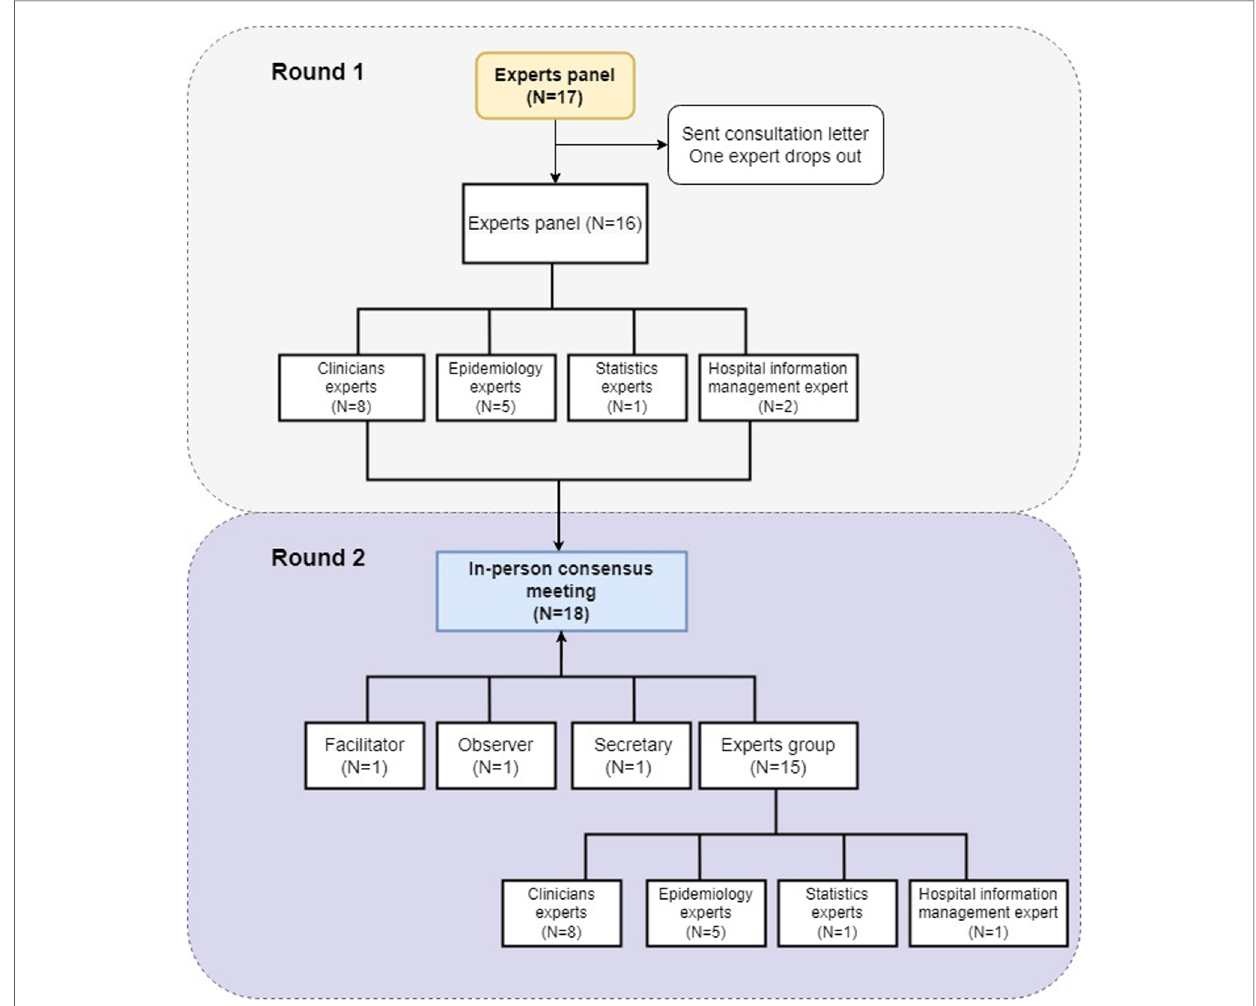
FIGURE 1 Flow chart of the modi fi ed Delphi method used to develop the Child Injury Surveillance CDS. Gray and purple indicate Round 1 and Round 2 of the Modi fi ed Delphi study,